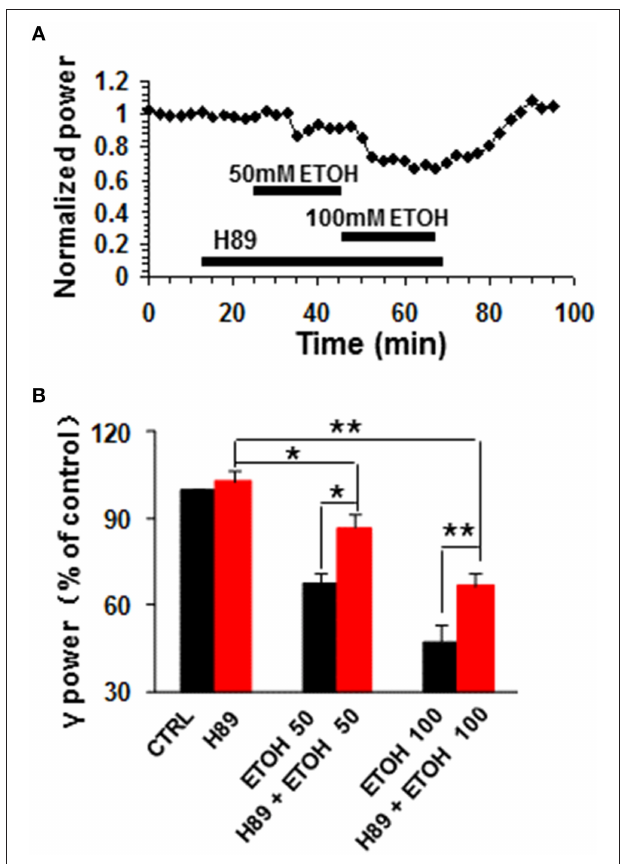
FIGURE 3 | The effects of PKA inhibitor on ethanol-induced suppression of γ oscillations. (A) Example of the effect of ethanol on γ power in the presence of the PKA inhibitor H89 (10 µ M). Details as in Figure 2A . (B) γ power as % of baseline for H89, 50 and 100mM ethanol ( n = 8). * P < 0.05; ** P < 0.01. Details as in Figure 2B